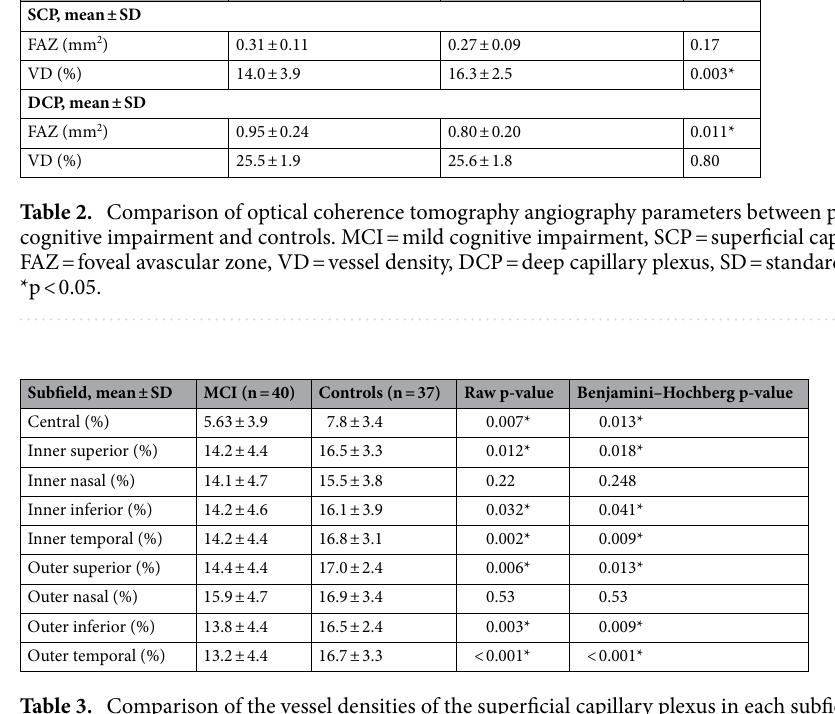
Table 3. Comparison of the vessel densities of the superficial capillary plexus in each subfield between the groups. MCI = mild cognitive impairment, SD = standard deviation. *p < 0.05.